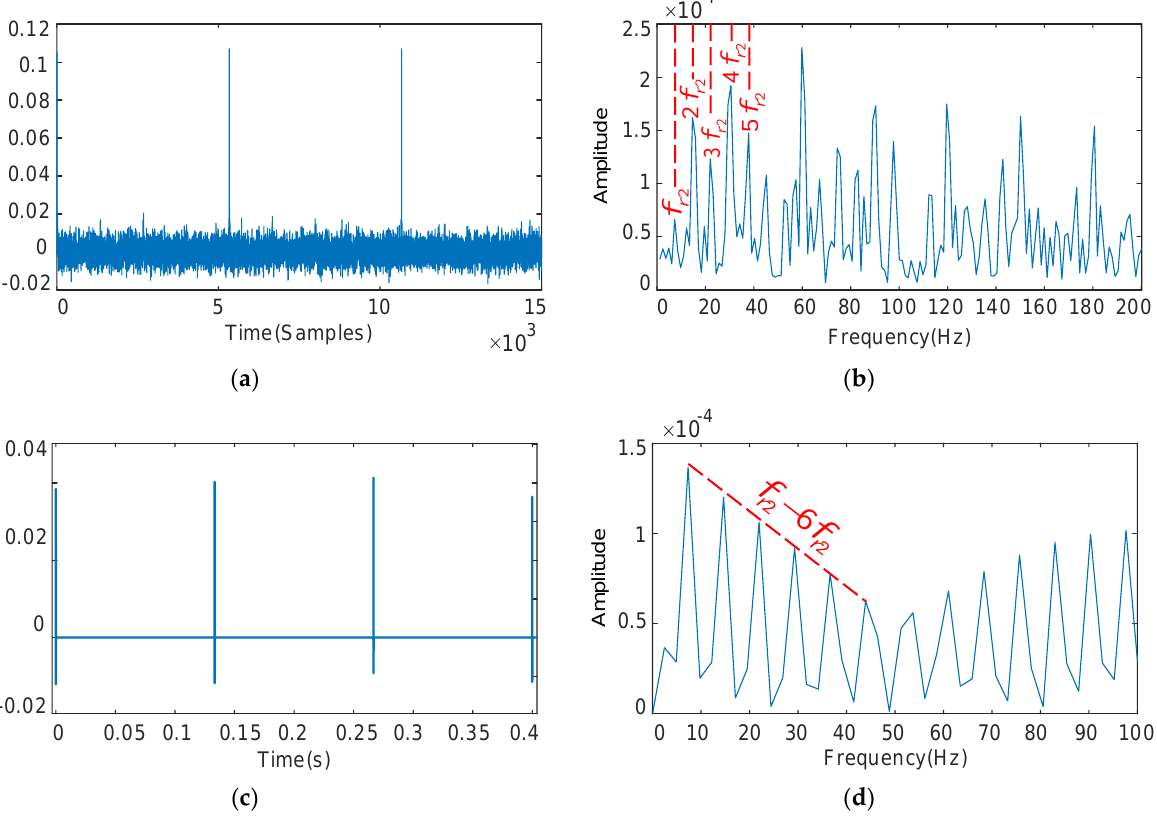
( d ) Figure 7. The decoupled pinion vibration signal and its frequency spectrum: deconvolution results of MOMEDA: filtered time domain waveforms and their frequency spectrum ( a , b ); Results obtained by MOMEDA and optimized RSSD: time domain waveforms and their frequency spectrum ( c , d ). The deconvolution period 2 r T